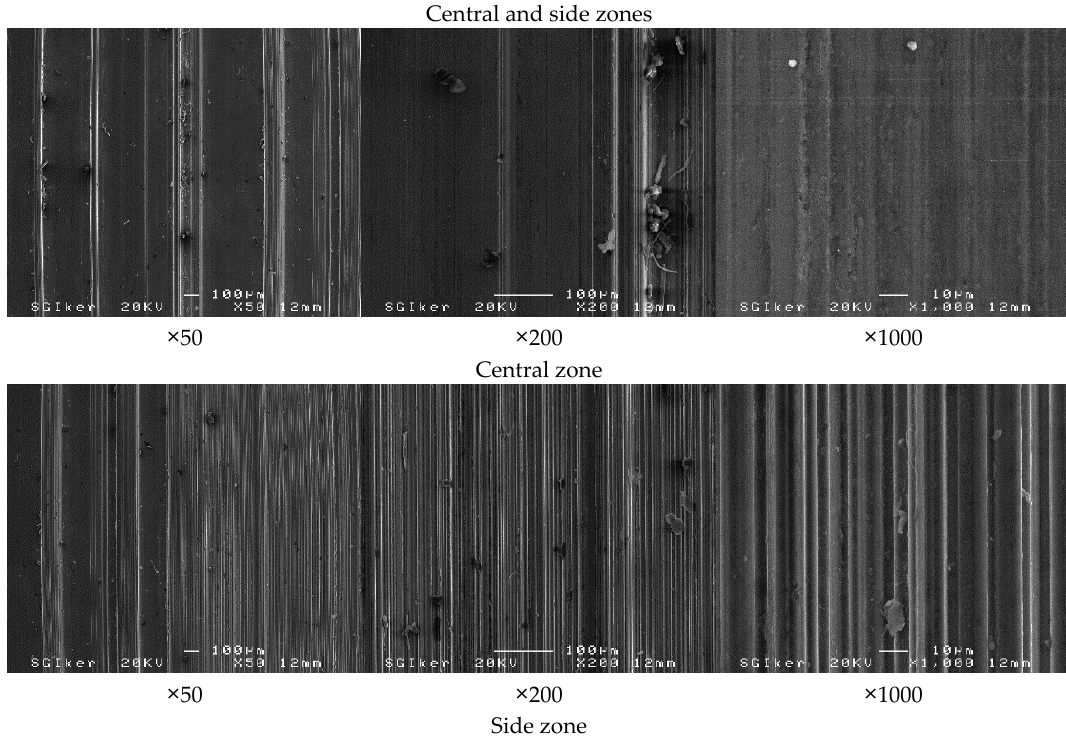
Figure 21. AA ‐ 5754 ‐ N2 disk. Figure 21. AA-5754-N2 disk.